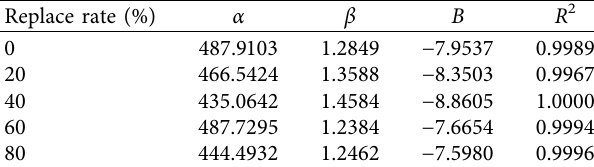
Figure 7: Correlation of characteristic parameter. Table 8: Weibull distribution characteristic